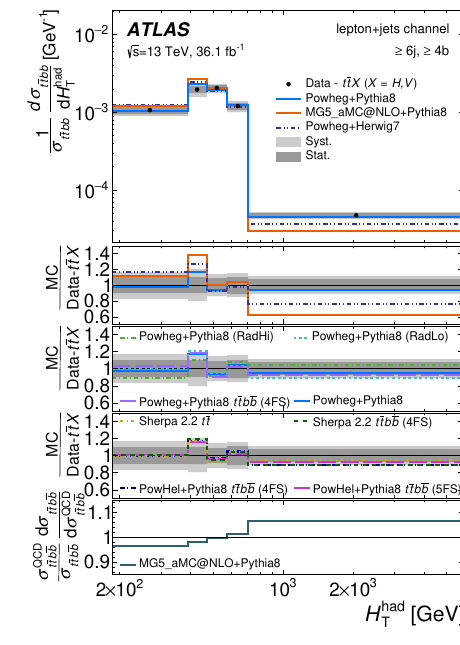
in events with at T